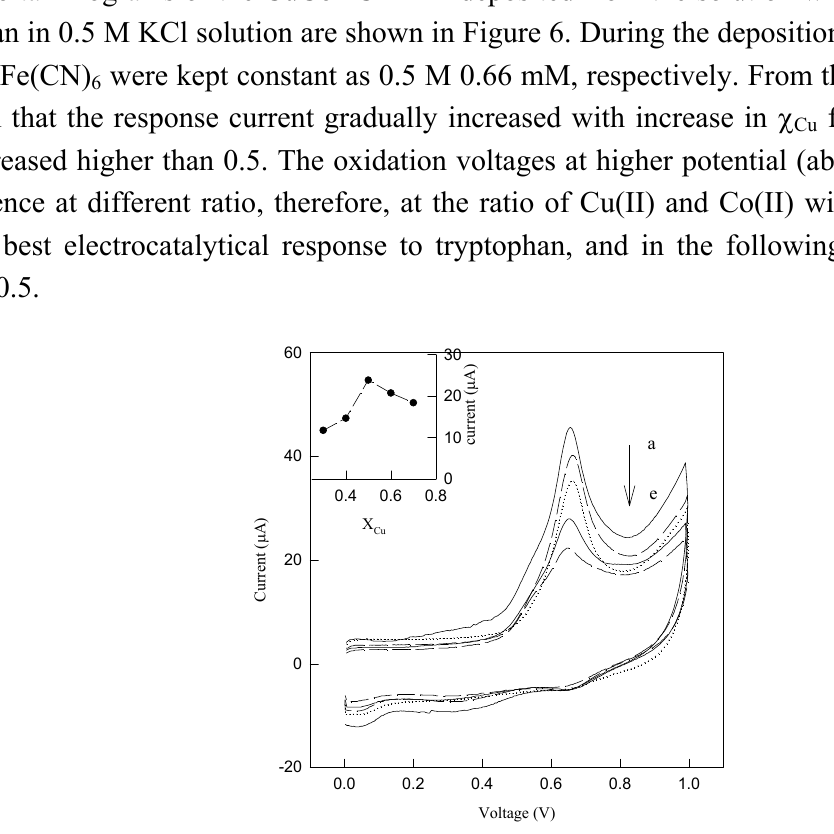
Fe(CN) : 0.66 mM. From a to e : 5:5, 6:4, 7:3, 3:7, 3 6